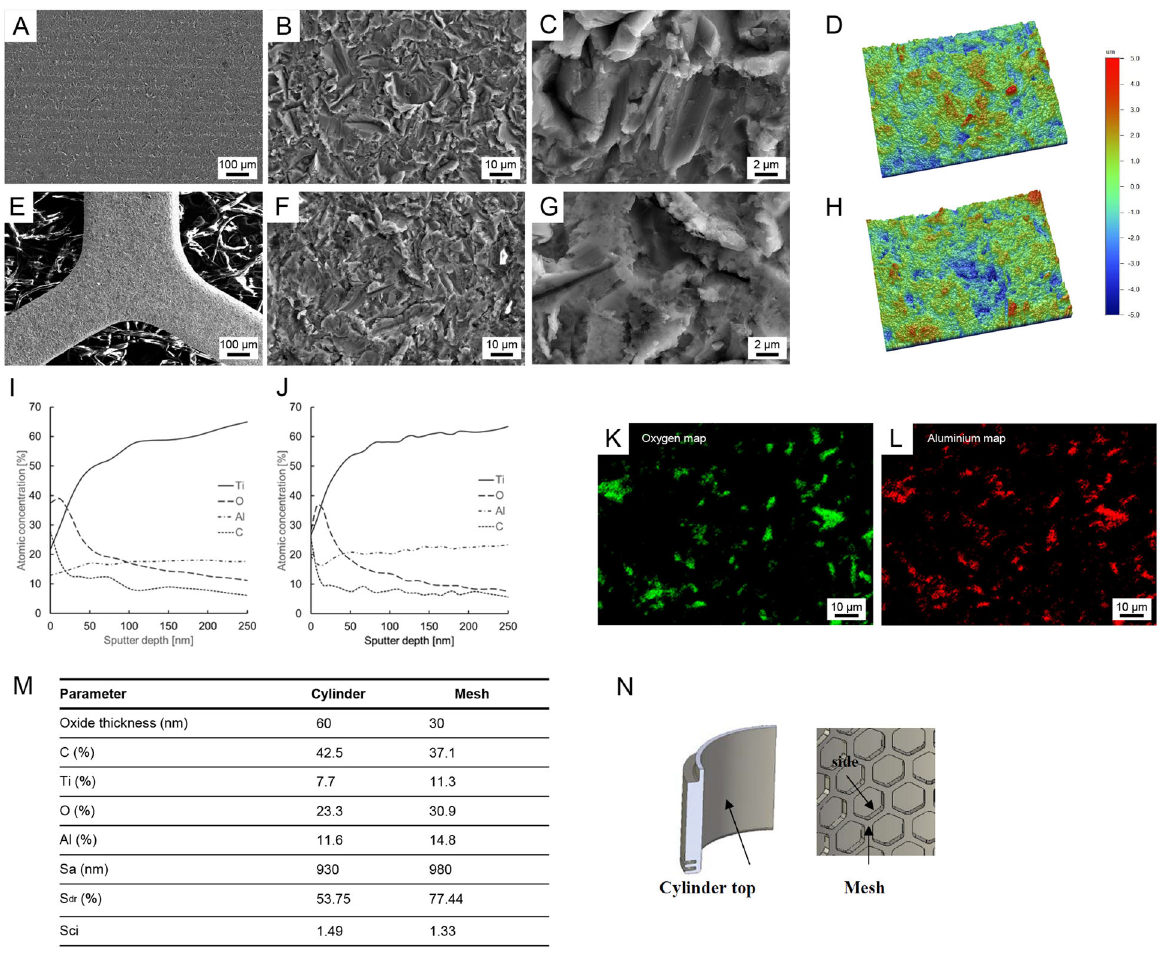
Fig. 2 A – N Qualitative and quantitative topographical and chemical characterisation of the stoma port with detailed analysis of the cylinder and mesh. A – D Scanning electron micrographs and surface micro- topography of the cylinder. E – H Scanning electron micrographs and surface microtopography of and the mesh. Auger electron spectro- scopy (AES) depth pro fi ling of the cylinder ( I ) and mesh ( J ). K, L Energy dispersive X-ray analysis (EDX) of the cylinder showing